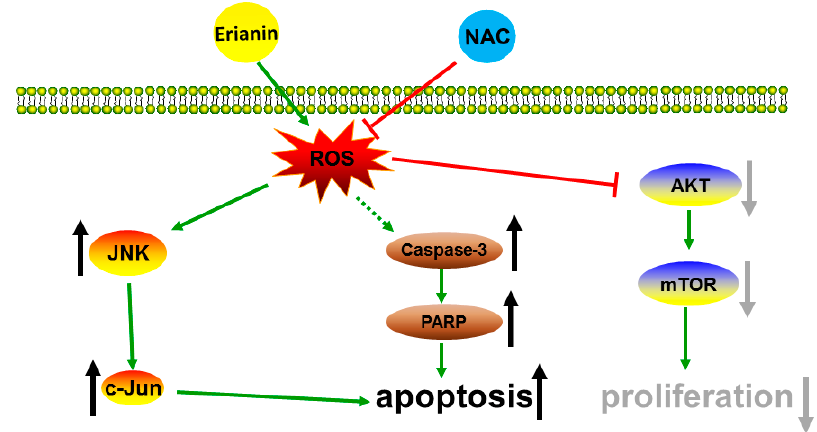
Figure 7. Schematic diagram of the potential mechanism of erianin-induced apoptosis and anti-proliferative effects in HaCaT cells.